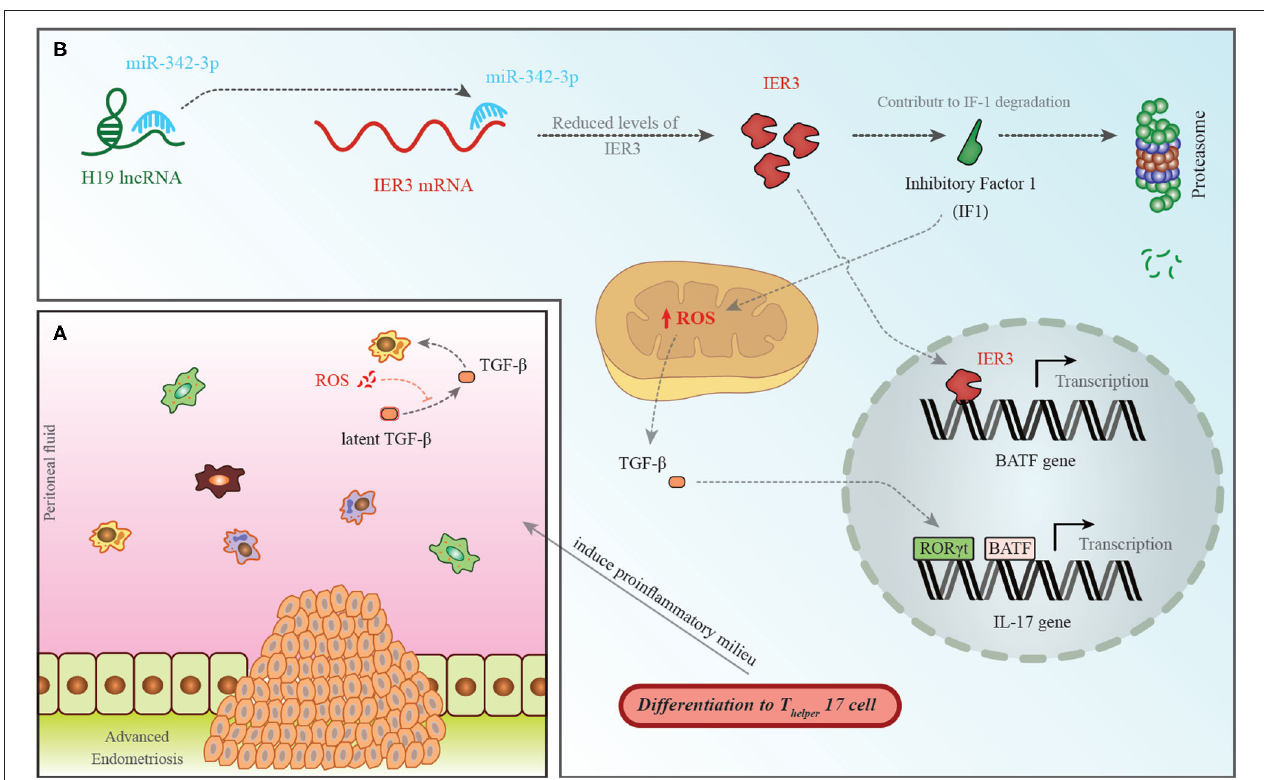
FIGURE 1 | (A) A pro-endometriotic microenvironment produced by an existing endometriotic lesion provides the appropriate micro-environment for the progression of this disorder. After the buildup of cells by a previously established lesion, these elements show distinctive features that destroy immune surveillance ( 96). (B) H19 levels have been shown to be decreased in the PBMCs of patients with endometriosis. This is accompanied with an increase in miR-342-3p levels. This miRNA binds with the 3 ′ UTR of IER3, thus inhibiting its expression ( 93). IER3 participates in proteasomal degradation of IF-1. Decrease in the levels of IF-1 leads to increase in reactive oxygen species (ROS) levels ( 97). ROS increases active extracellular TGF- β levels. This cytokine influences ROR γ t, thus activating transcription of IL-17 and leading to differentiation of TH17 cells